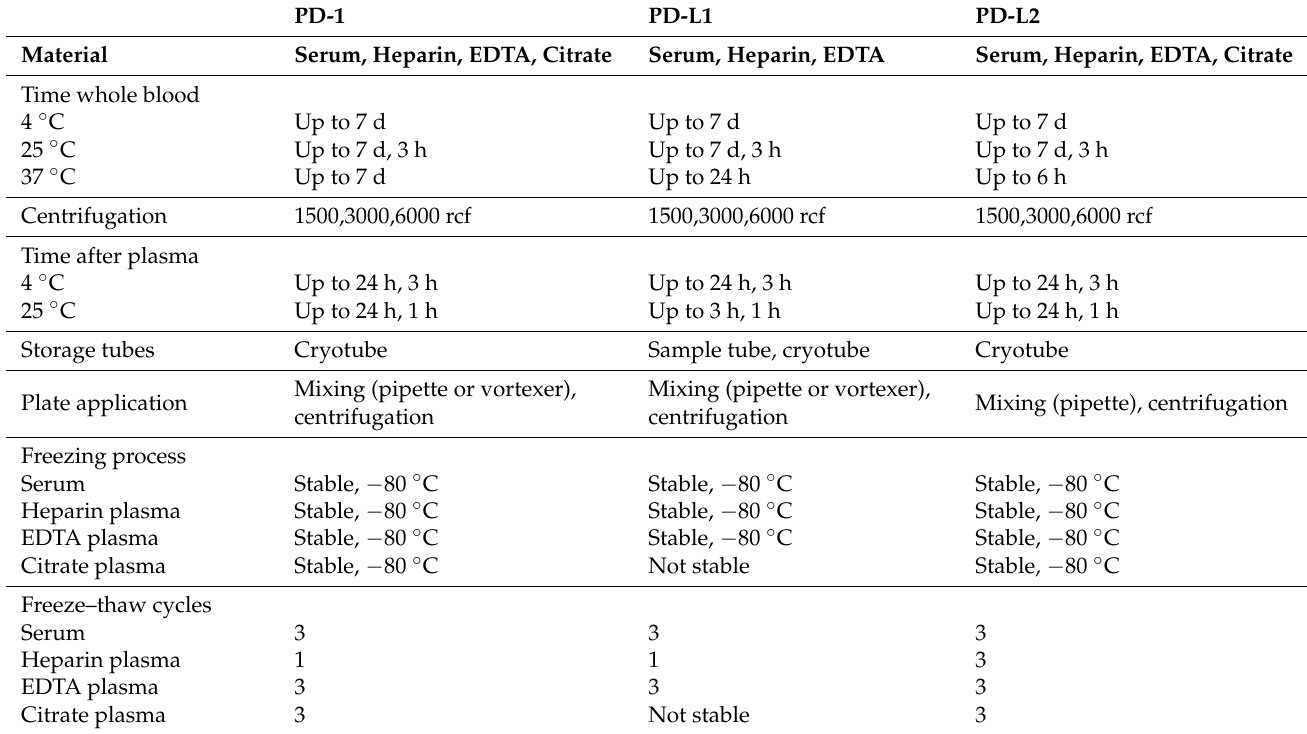
Table 2. Final selected conditions for the standard operating procedure for PD-1, PD-L1, and